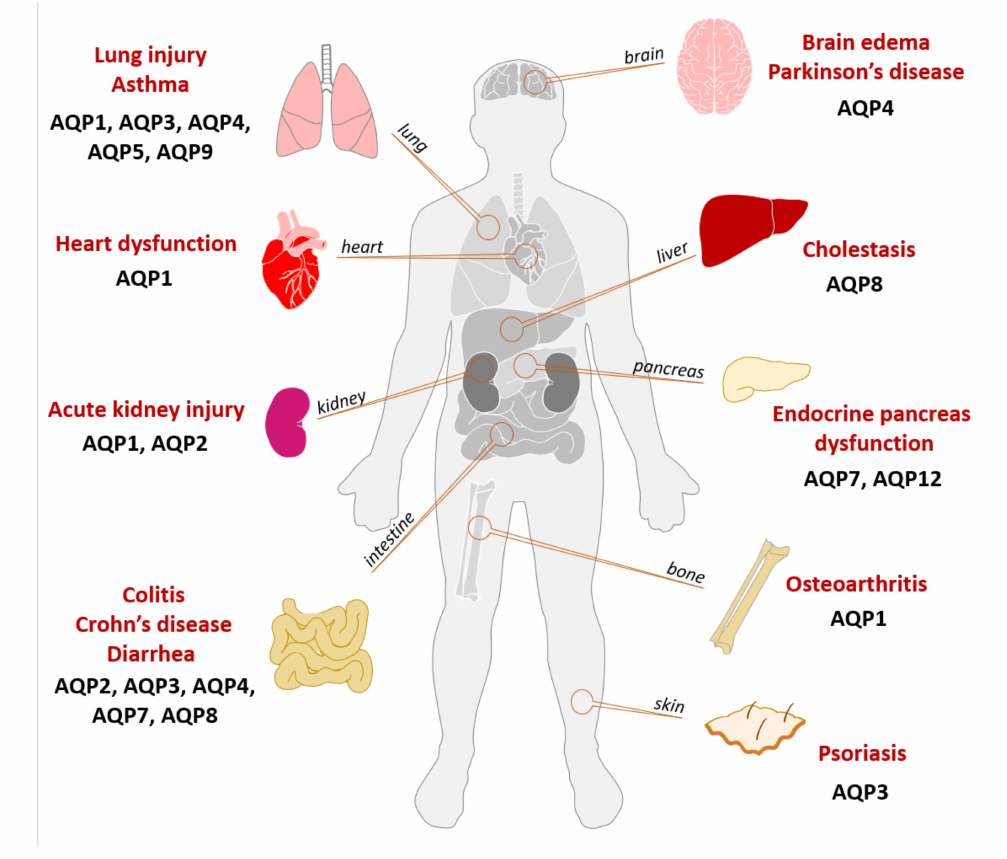
Figure 3. Involvement of AQPs in inflammatory diseases. Illustration of the various AQP isoforms involved in inflammation-associated diseases and respective affected